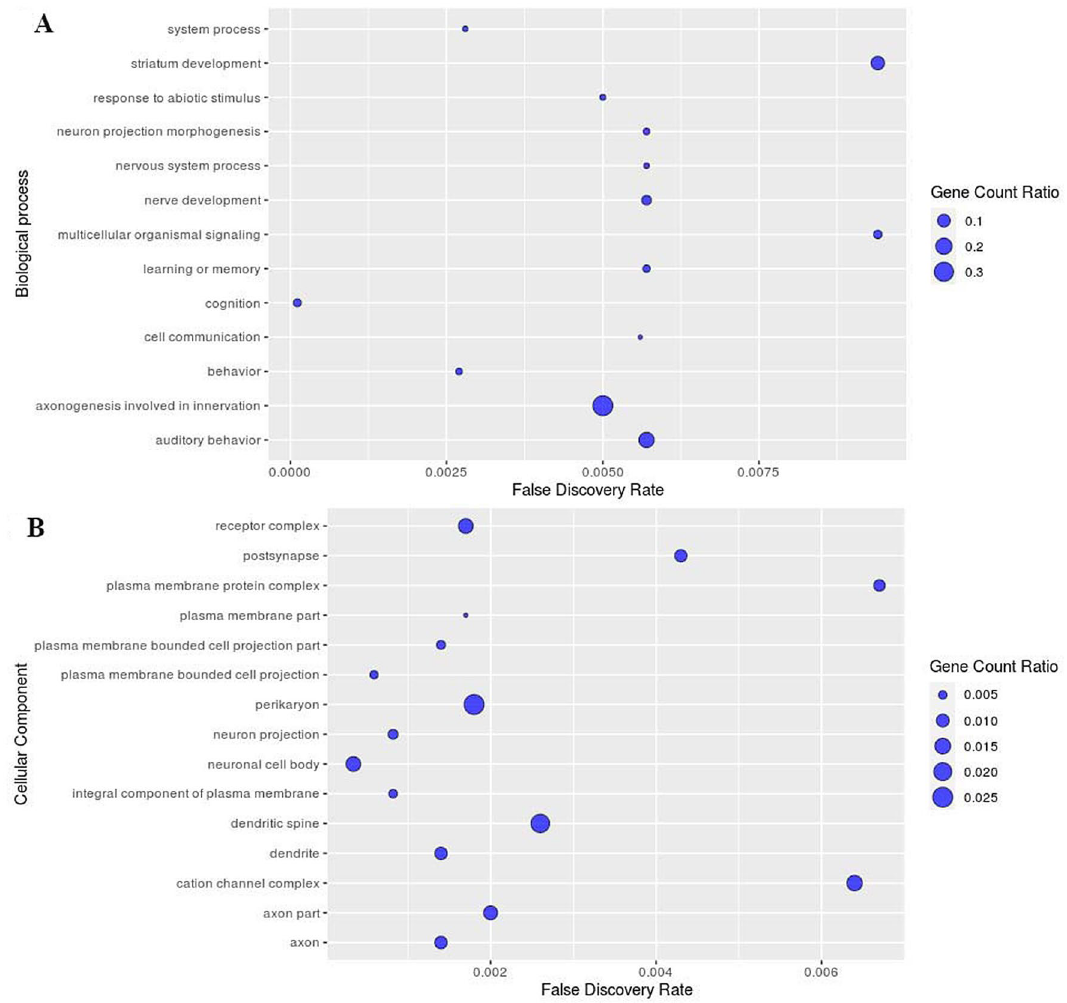
Figure 2. Gene ontology enrichment plots for positively selected SNPs showing ( A ) biological processes with their FDR cut off and gene count ratio ( B ) cellular processes with their FDR cut off and gene count